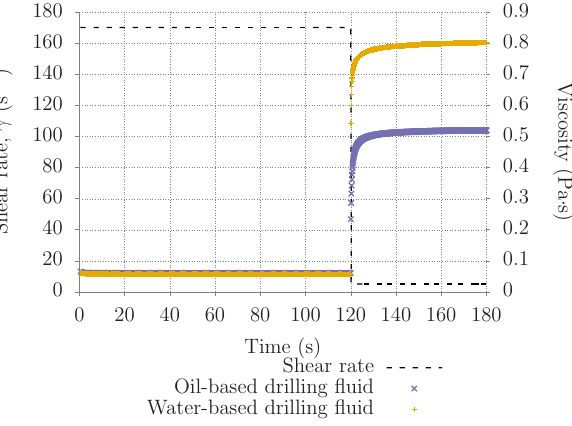
Figure 3: Stress overshoots in the WBM and the OBM following different resting times.